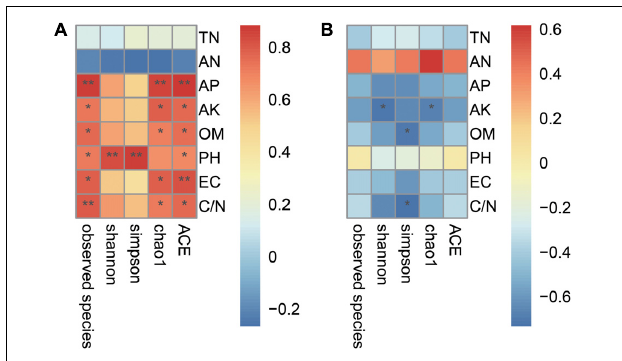
FIGURE 3 | The relationships of microbial alpha diversity and soil chemical properties. Panel (A) showed the relationship of bacterial diversity and soil chemical properties; (B) showed the fungal diversity and soil chemical properties. The numbers on the right stands for the relationship between the diversity indexes and soil chemical properties based on the Pearson’s correlation analyses. Asterisks denote significant relationship between the microbial diversity indexes with the soil chemical properties (* P < 0.05, ** P < 0.01).